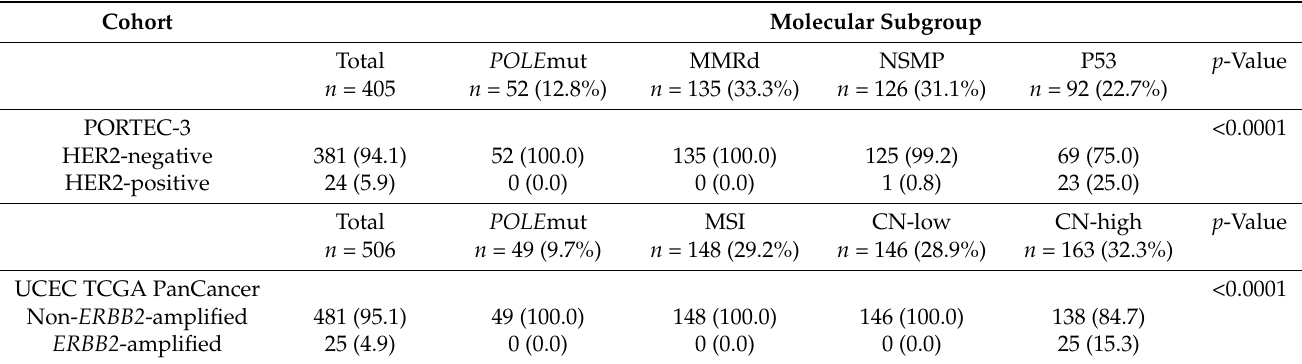
Figure 2. Three examples of HER2-positive endometrial cancers (EC) of non-serous histology. ( A ) H&E of an EC diagnosed as International Federation of Gynecology and Obstetrics (FIGO) grade 2 endometrioid EC (EEC) with ( B ) aberrant mutant-like p53 immunostaining, ( C ) strong (in)complete membranous HER2 immunostaining, and HER2 gene amplification by dual in situ hybridization (DISH). ( D ) H&E of an EC diagnosed as FIGO grade 3 EEC with ( E ) aberrant mutant-like p53 immunostaining, ( F ) strong complete membranous HER2 immunostaining, and HER2 gene amplifi- cation by DISH. ( G ) H&E of an EC diagnosed as endometrial clear cell carcinoma with ( H ) aberrant mutant-like p53 immunostaining, ( I ) strong complete membranous HER2 immunostaining, and HER2 gene amplification by DISH. All images × 20 objective magnification. Table 2. Association between the HER2 status and molecular EC